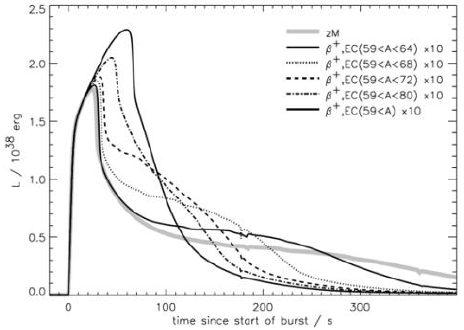
Fig. 1. Taken from [6]: sensitivity of the light curve of the first pulse in model zM to variations along the waiting points in the vicinity of A = 60, 64, and 68. The nominal light curve is shown along with the result when all weak rates above A = 59 are multiplied by